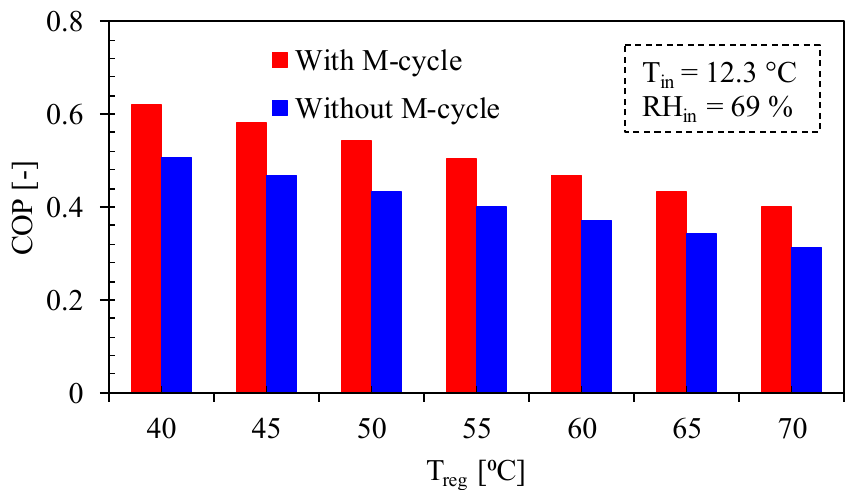
Figure 6. Coe ffi cient of performance (COP) of desiccant-based AC system options equipped Figure 6. Coefficient of performance (COP) of desiccant ‐ based AC system options equipped (with / without) M-cycle unit. (with/without) M ‐ cycle unit.